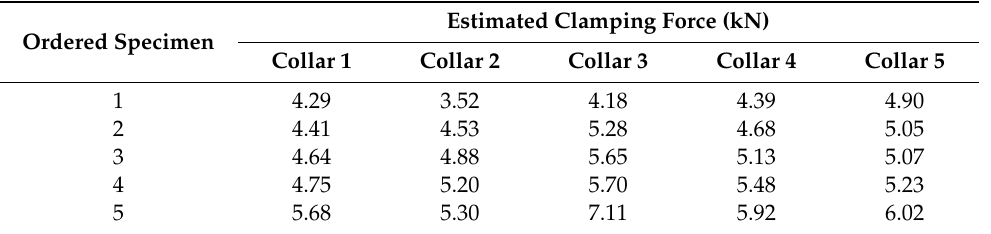
Table A6. Experimental data for clamping force for shear fatigue tests—Figure 8c. Ordered